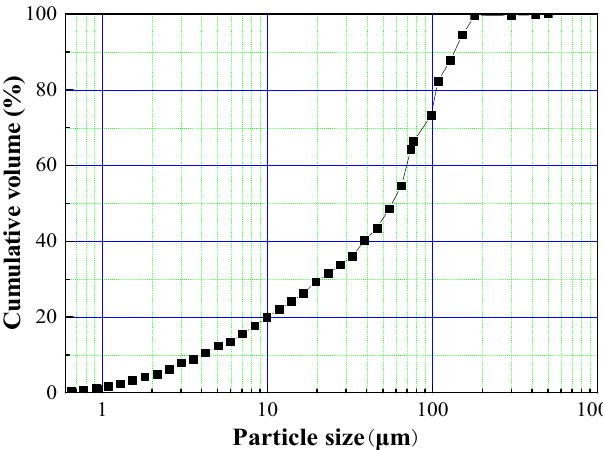
Figure 3. Particle size distribution of the unclassified tailings.